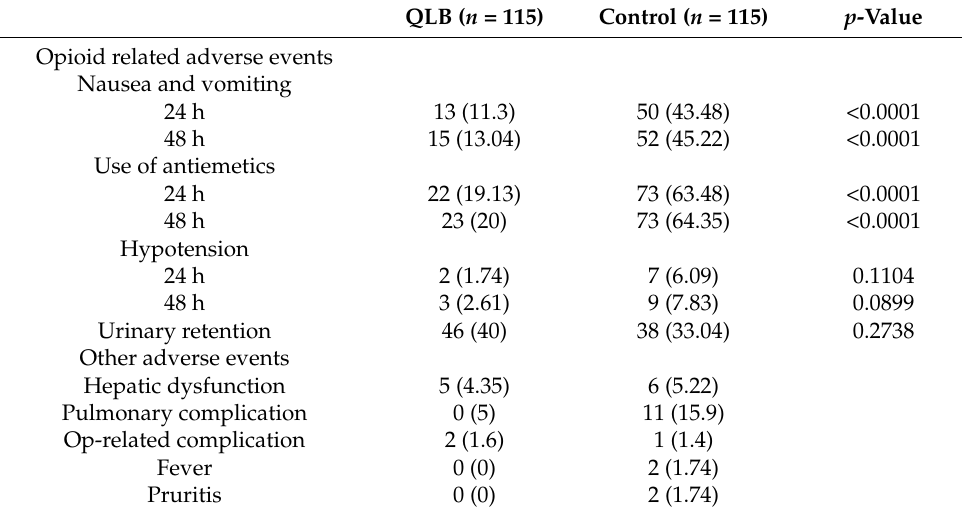
Table 2. Incidence of adverse